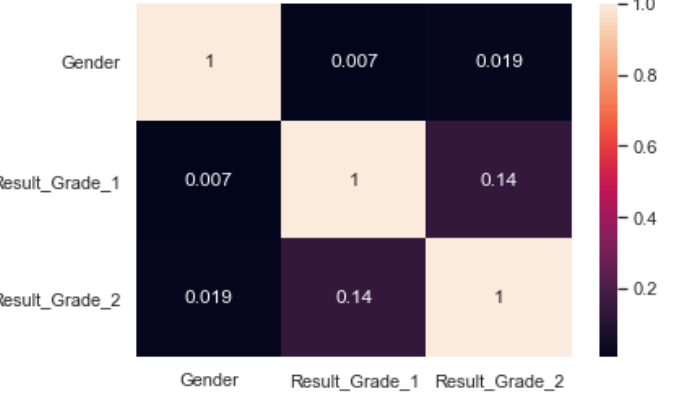
Figure 2. Correlation between students’ genders and final statuses for the CES database.